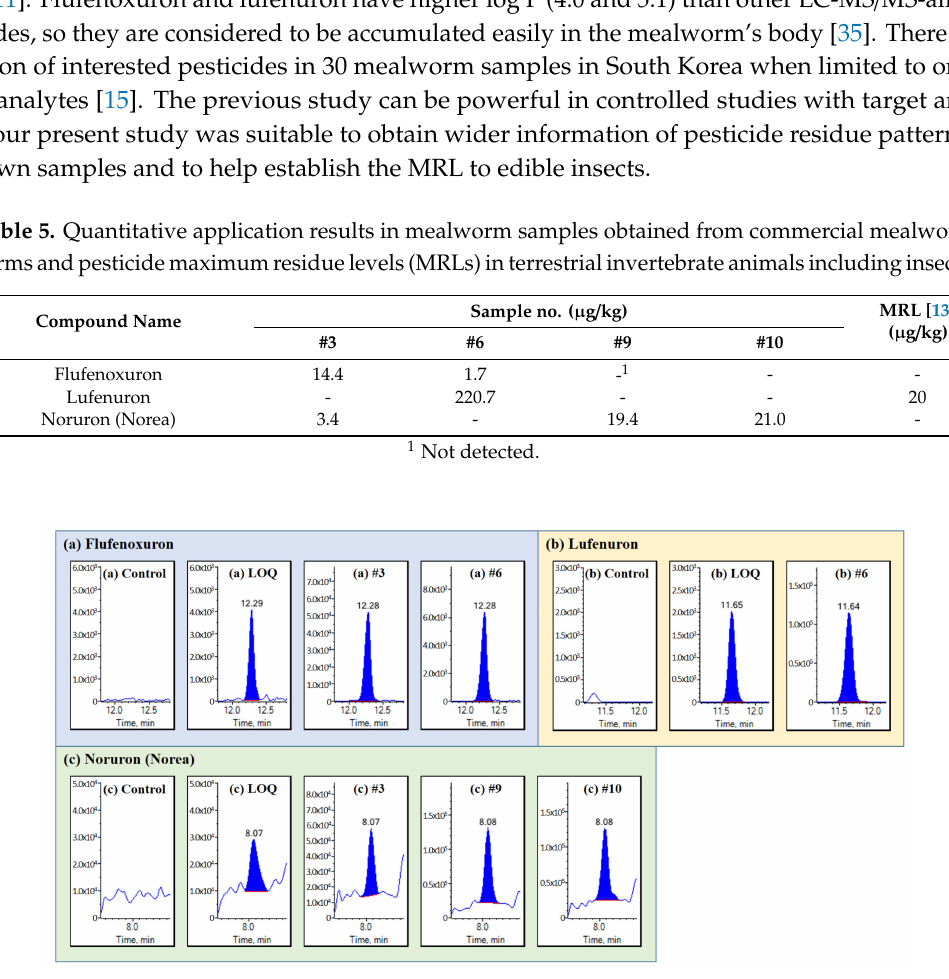
Figure 3. Chromatograms of ( a ) flufenoxuron from the control, LOQ, and mealworm samples (#3 and #6), ( b ) lufenuron from the control, LOQ, mealworm samples (#6), and ( c ) noruron (norea) from the control, LOQ, and agricultural workers (#3, #9, and #10). The multiple reaction monitoring (MRM) transitions in the chromatograms were 489.1 > 158.2 (flufenoxuron), 510.9 > 158.2 (lufenuron), and 223.2 > 67.1